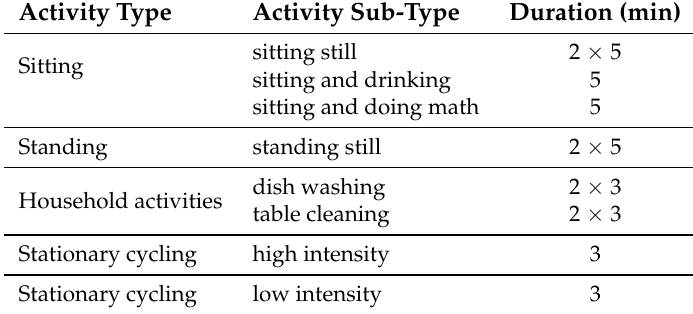
Table 1. The set of activities included in the study protocol. Those subjects who were physically active (activity class ≥ 5, range 1–10) were instructed to cycle at a 100-Watt power level, while those who were less physically active (activity class < 5, range 1–10) were instructed to cycle at 50-Watt power level